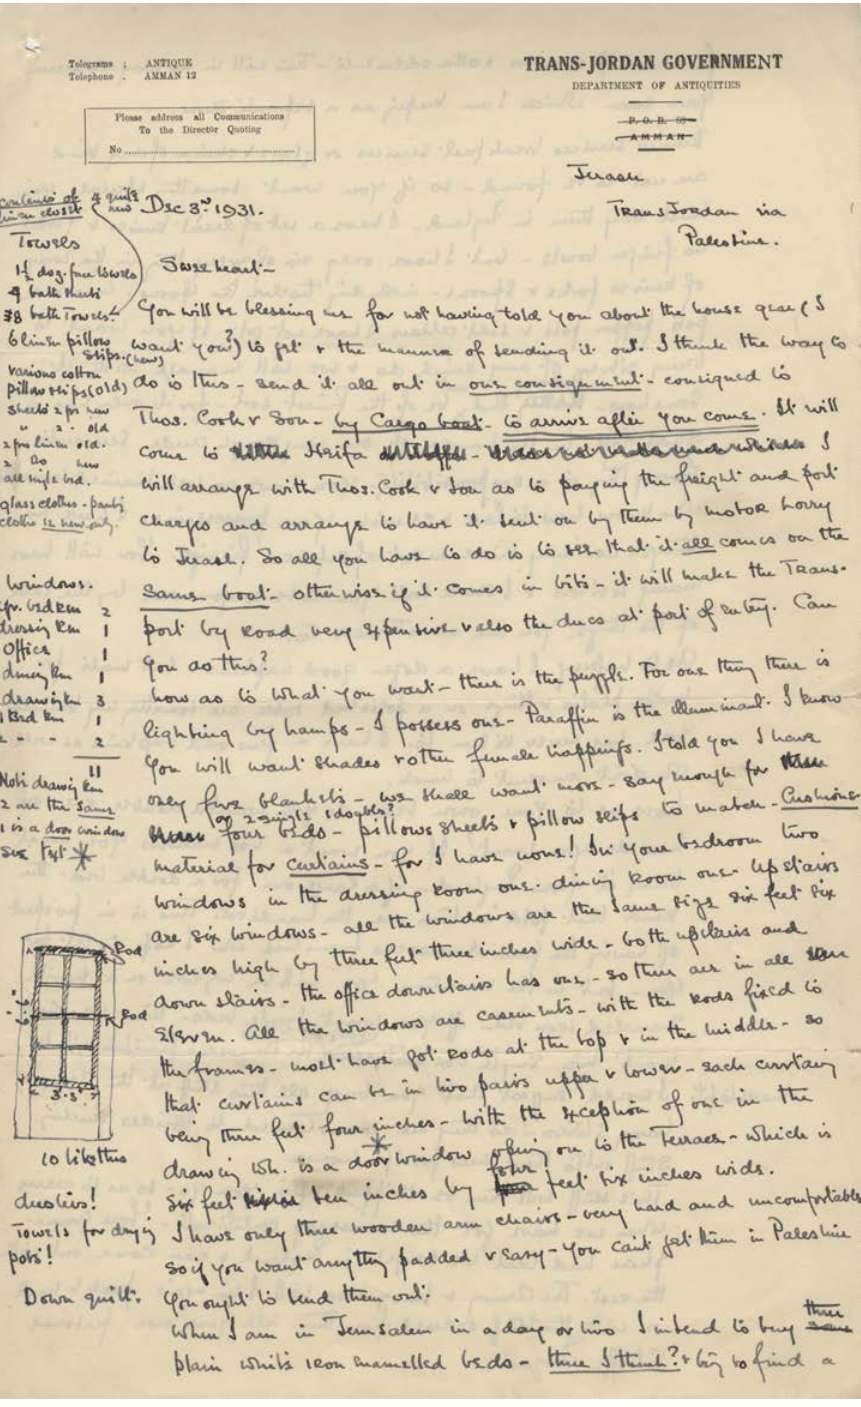
Fig. 1: The first page of a letter from Horsfield to Conway, written on Transjordan Department of Antiquities stationery. (Copyright UCL Institute of